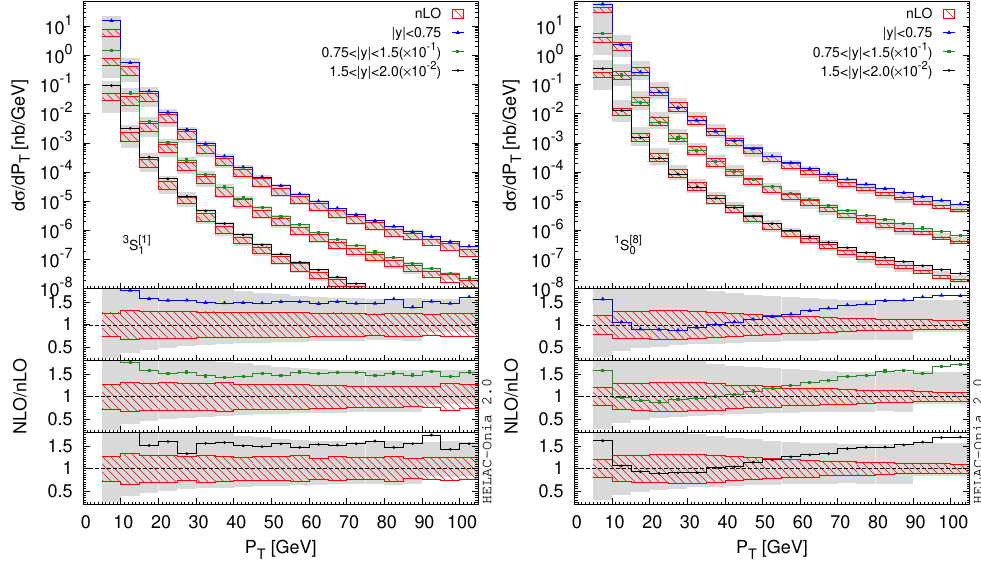
Figure 8 . Comparisons of spin-summed differential cross sections for the Fock states 3 S [1] between our nLO calculations and the complete NLO calculations.